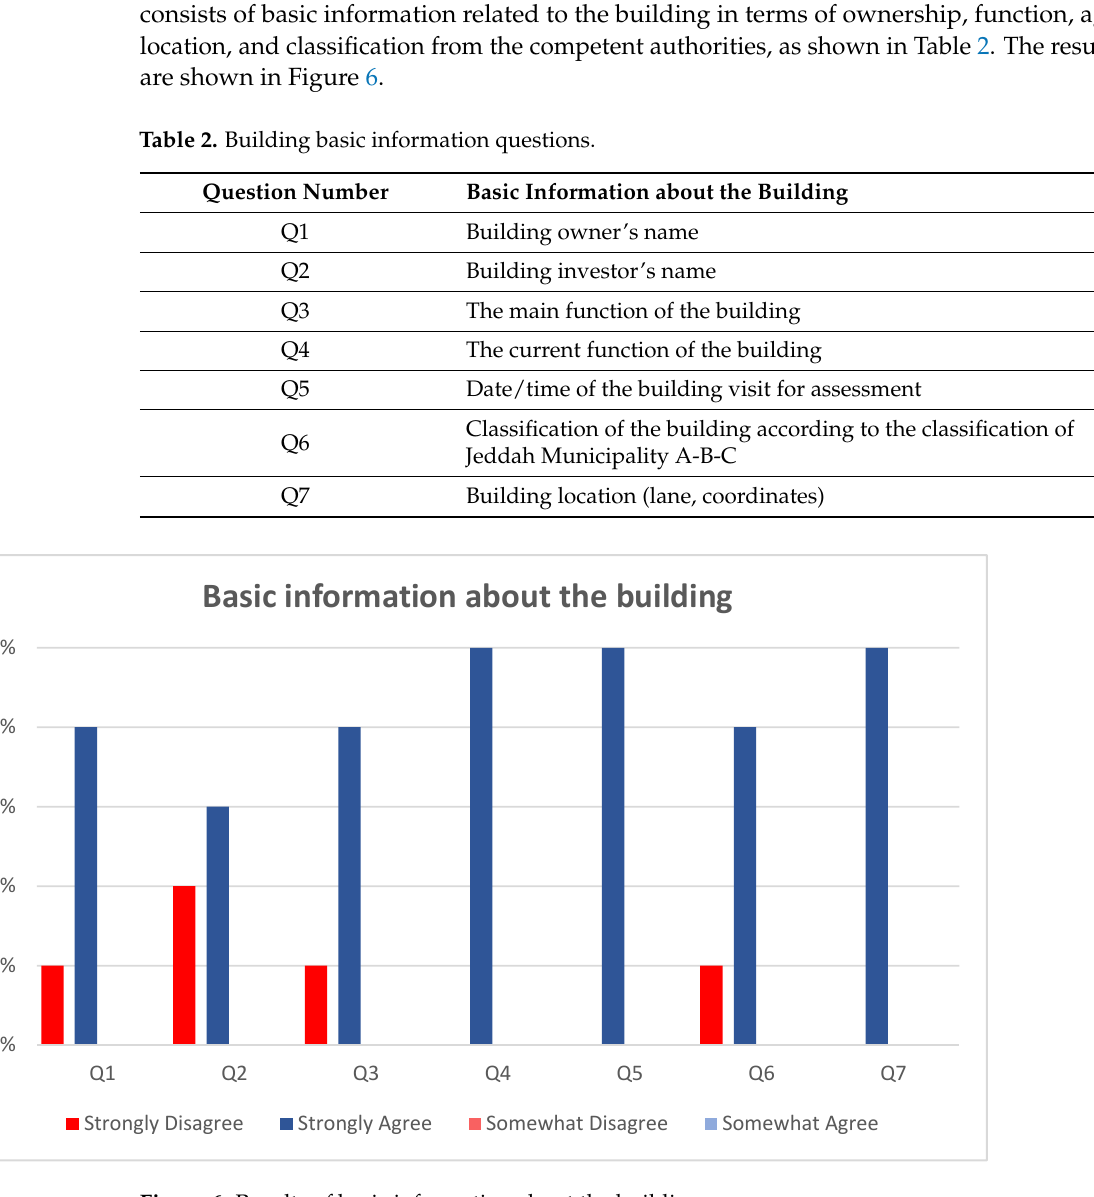
Figure 6. Results of basic information about the